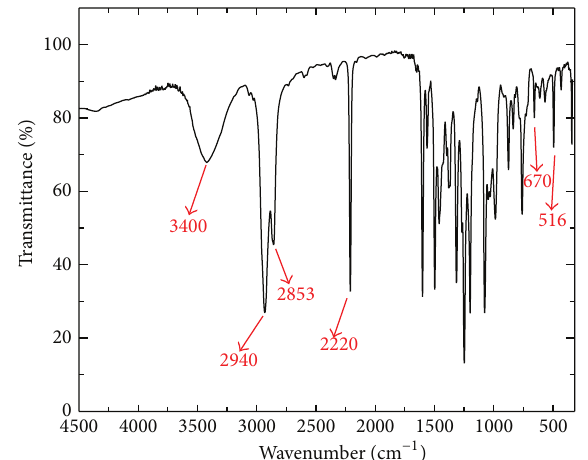
Figure 7: FTIR spectrum of 4-[(6-bromohexyl)oxy]-2,5-dimeth-